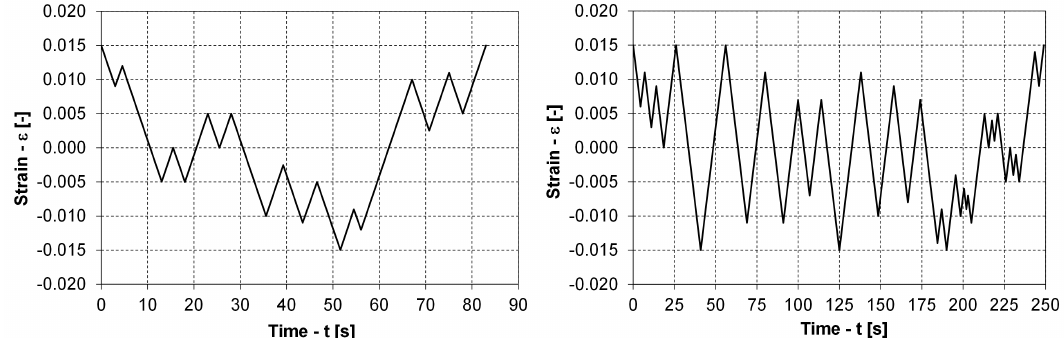
Figure 6. Two variable strain time series for the low-cycle fatigue experiments.